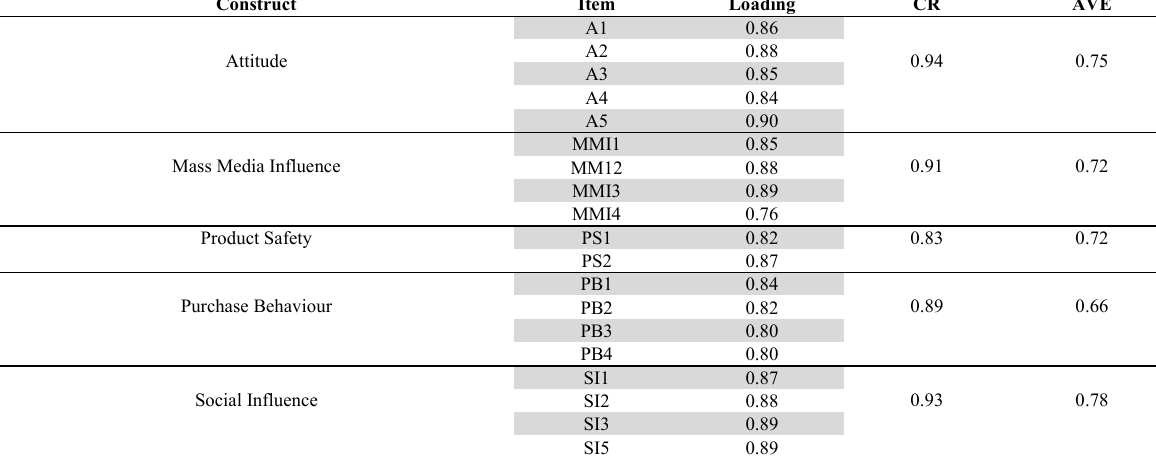
The Result of Construct Validity and Reliability